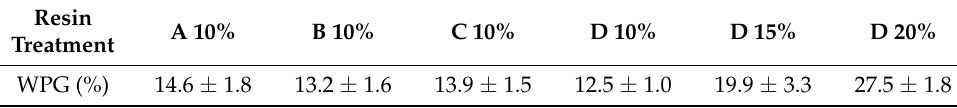
Table 2. Veneer WPG after treatment with PF resin